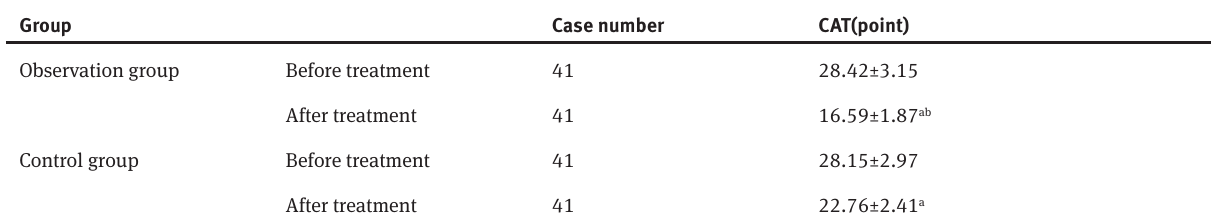
Table 7: Comparison of CAT score between two groups before and after treatment ( ±s)